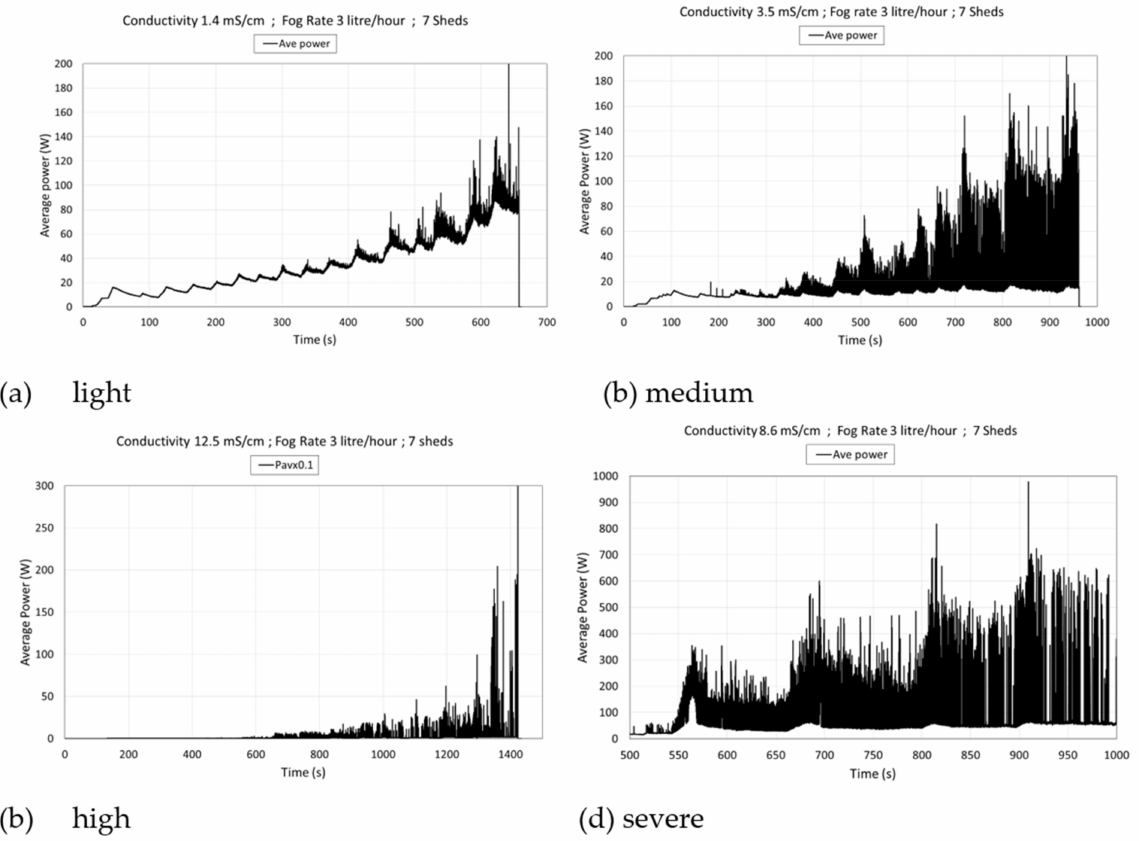
Figure 21. Calculated average power for various pollution levels. ( a – d ) are the pollution